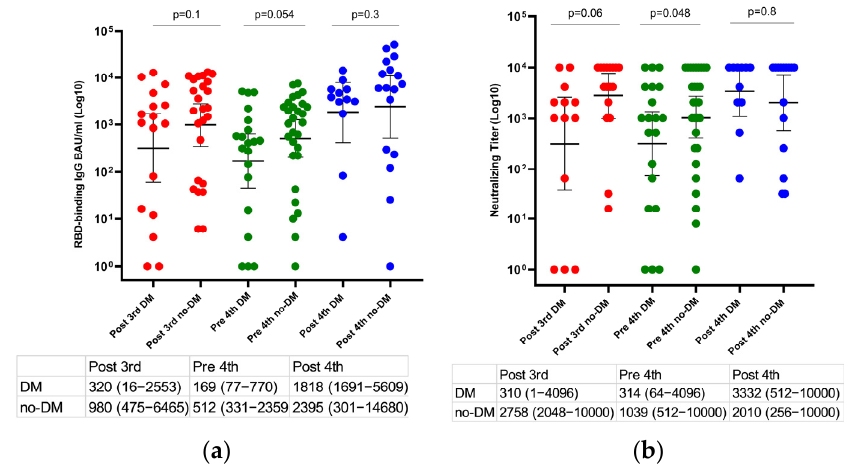
Figure 4. Changes in the humoral immune response after the third and the fourth vaccine doses among liver transplant recipients with and without diabetes mellitus. (a) Scatter plot presenting changes in anti-RBD IgG and (b) SARS-CoV − 2 pseudo-virus neutralizing antibody titers after the third and the fourth vaccine dose (post-third serum collection was 22 days (IQR, 21–28 days) after the third vaccine, the pre-fourth was 131 days (IQR, 129–137 days) after the third dose, and the post- fourth was 29 days (IQR, 25–33 days) after administration of the fourth vaccine dose). Differences in paired samples were calculated using the Wilcoxon matched-pairs signed-rank test. The horizon- tal line indicates geometric mean values with a 95% confidence interval.